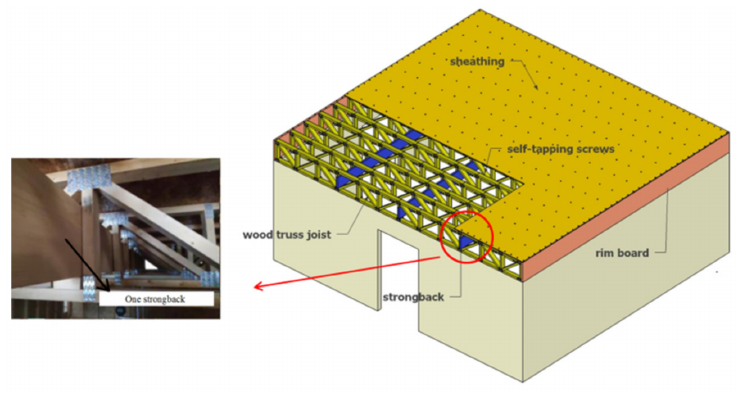
Figure 1. Sketch map of wood truss joist floor